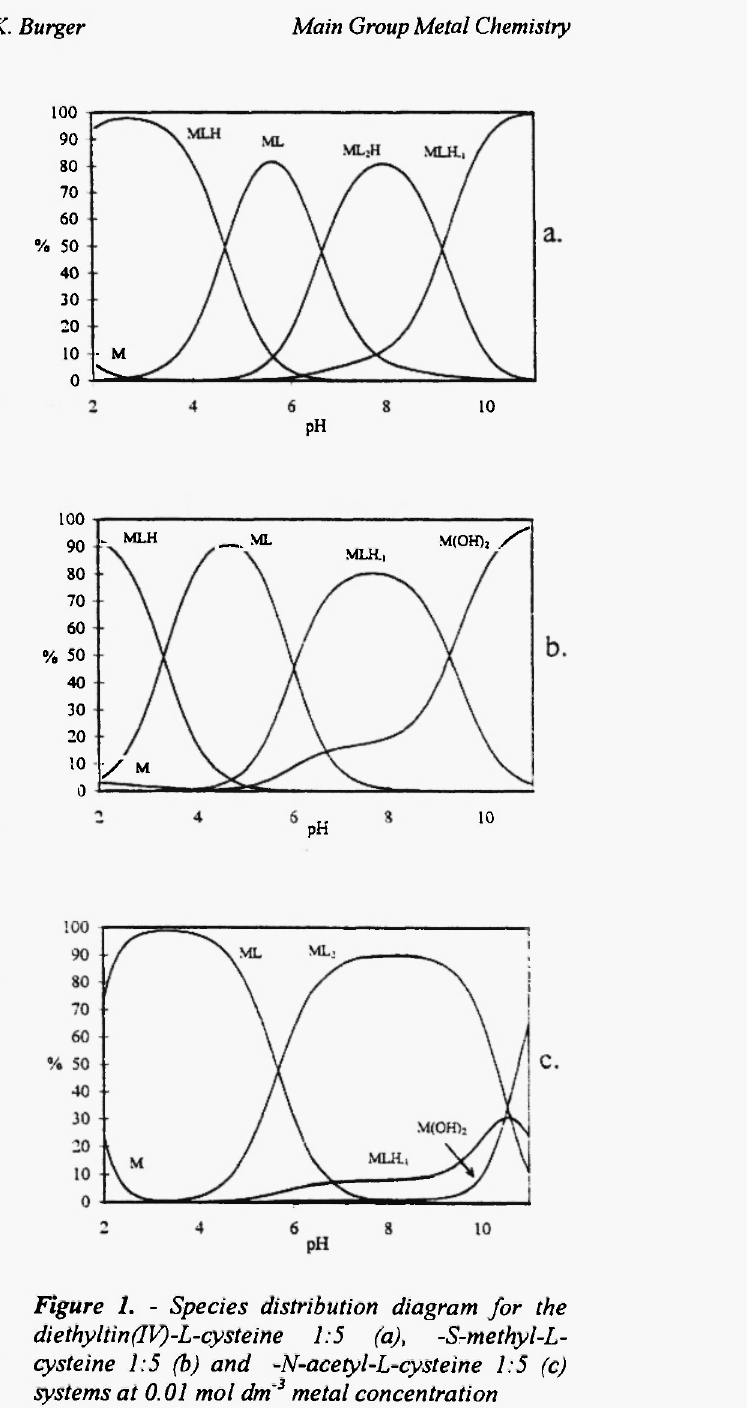
Figure 1. - Species distribution diagram for the diethyltin(IV)-L-cysteine 1:5 (a), -S-methyl-L- cysteine 1:5 (b)